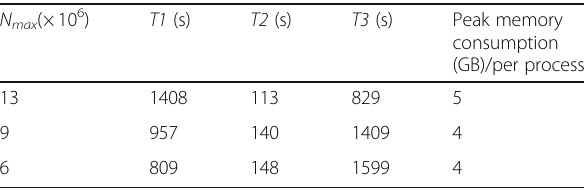
Table 2 Results for different N max